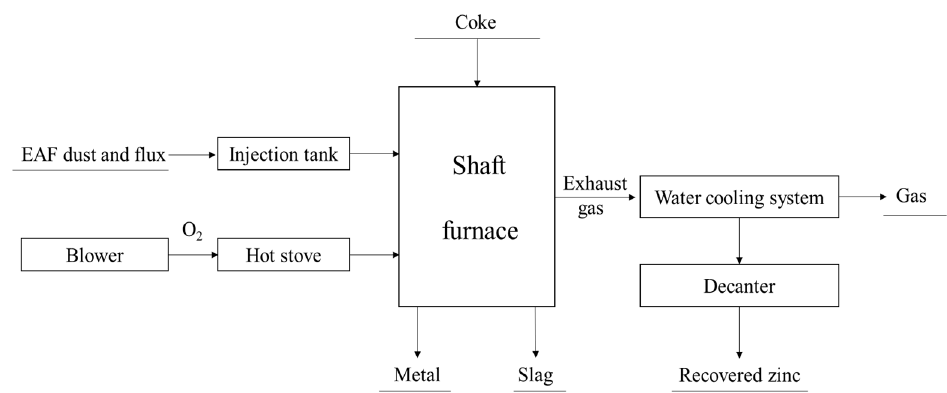
Figure 11. Flow chart of coke-packed bed process